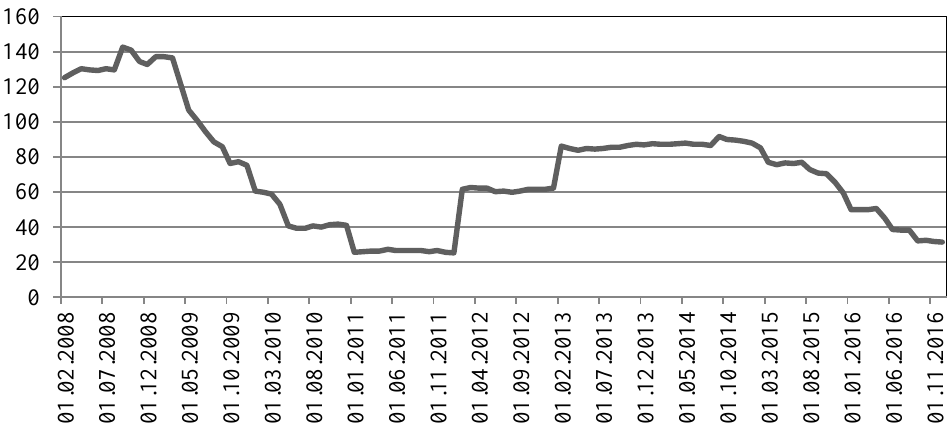
Fig. 11. The trends of volume of the Reserve Fund assets in 2008–2016, in bln USD (compiled by authors to: